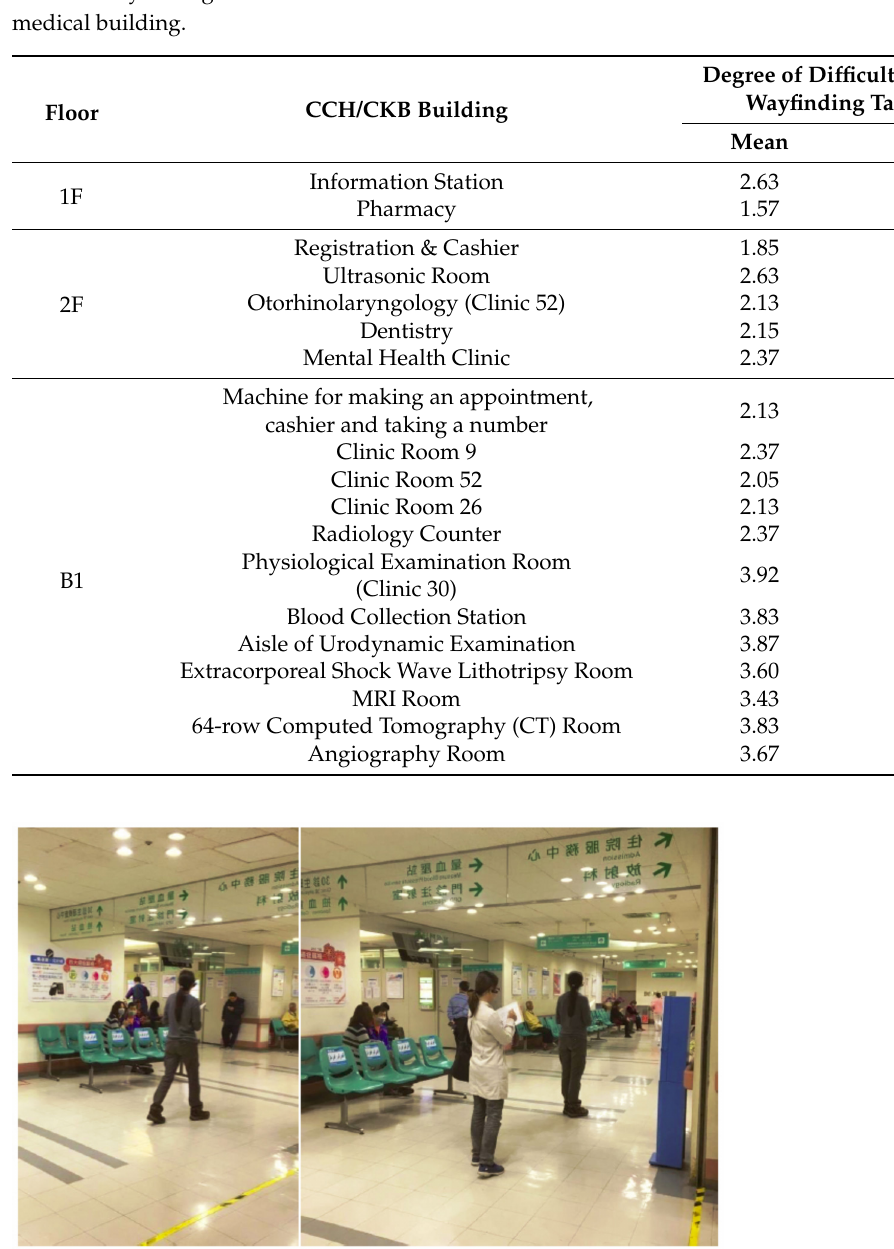
Figure 9. The research recorder observed and recorded the participants performing the wayfind- ing